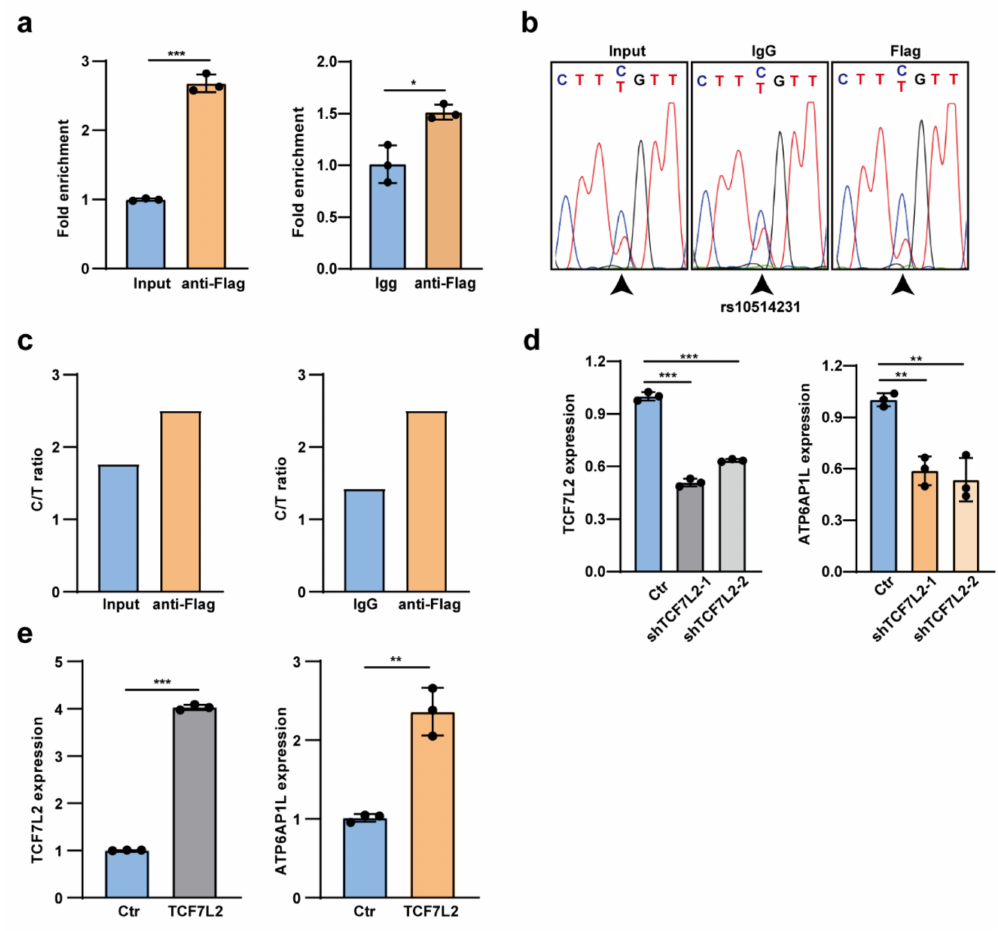
Figure 6. TCF7L2 binds the rs10514231 region and regulates the ATP6AP1L gene expression. ( a ) ChIP-qPCR analysis for TCF7L2 chromatin binding at the rs10514231 region. Input DNA and IgG ChIP DNA were used as the negative control. Values are the means ± SD; * p < 0.05, *** p < 0.001, two-tailed Student’s t -test. ( b ) Sanger sequencing chromatogram with the PCR product of ChIP DNA and input DNA. ( c ) The under-peak area of C and T alleles in ( b ) was quantified by EditR 1.0.9 online software. ( d ) RT-qPCR analysis of ATP6AP1L expression in MDA-MB-453 cells with lentiviral TCF7L2 shRNA knockdown. Values are the means ± SD; ** p < 0.01, *** p < 0.001, two-tailed Student’s t -test. ( e ) The mRNA expression level of the ATP6AP1L gene in MDA-MB-453 cells upon lentiviral overexpression of the TCF7L2 gene. Values are the means ± SD; ** p < 0.01, *** p < 0.001, two-tailed Student’s t